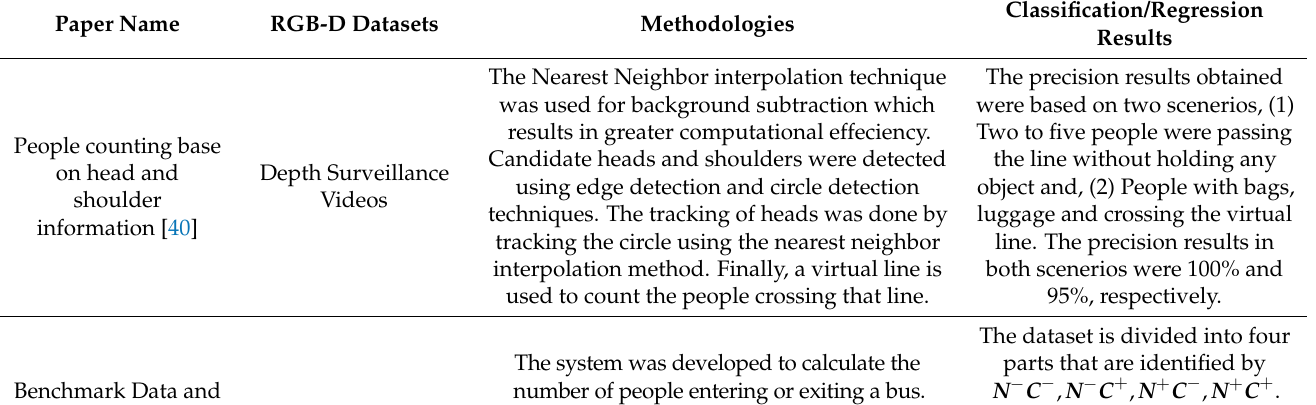
Table 2. Detailed explanation of head tracking and counting systems that used RGB-D